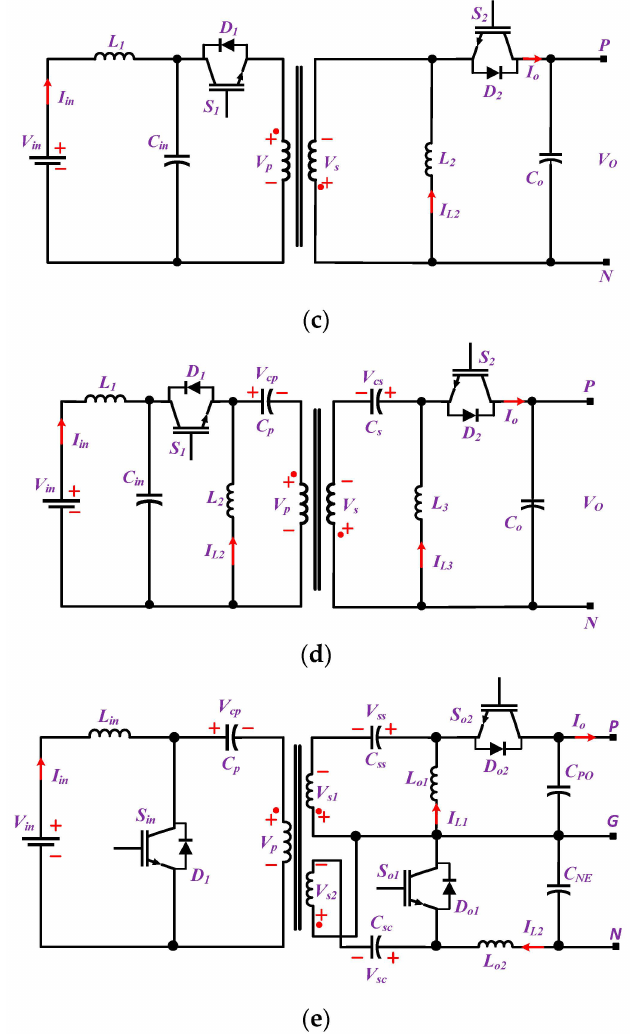
Figure 16. SMPS used in the MMI in Figure 11: ( a ) Cuk (C5) [27], ( b ) F5 [27], ( c ) Sepic (G5) [27], ( d ) P5 [27], and ( e ) hybrid of SEPIC/CUK converter